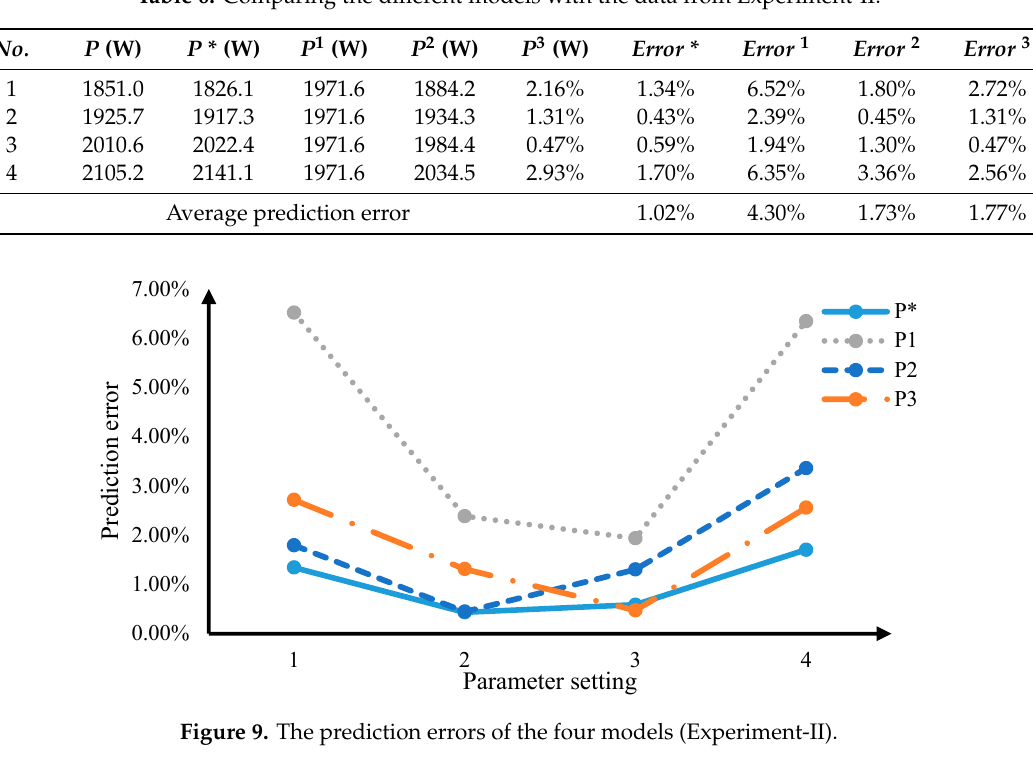
Table 6. Comparing the di ff erent models with the data from Experiment-II.